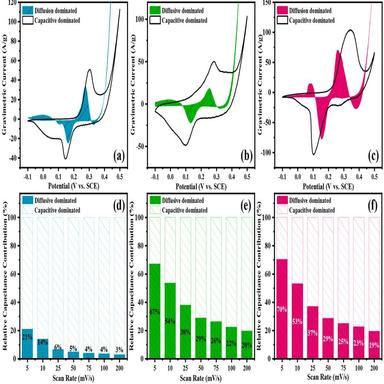
Capacitive and diffusion-controlled contribution to charge storage of a) ZnAl-LDH, b) CoAl-LDH and c) NiAl-LDH electrodes; Diffusive and capacitive contribution of electrical capacity of electrodes at various scan rates.